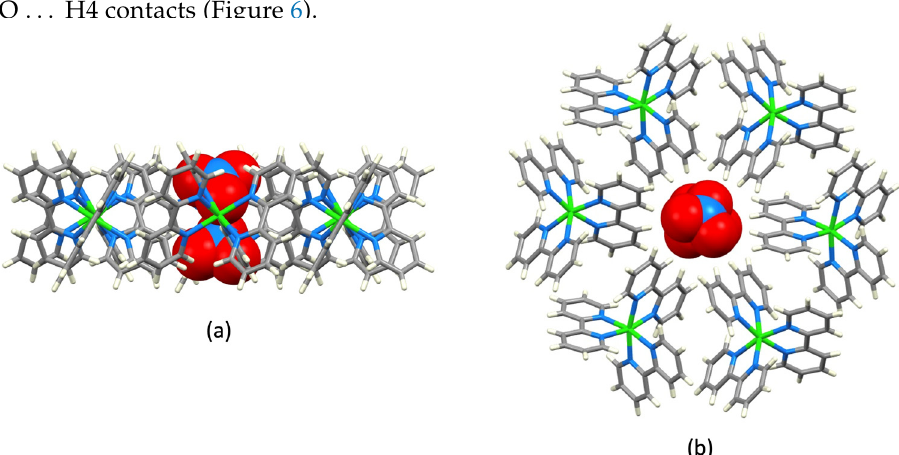
Figure 5. Structure Type II illustrated with the motif found in [Zn(bpy) 3 ][NO 3 ][azt] 0.5 . 6H 2 O which possesses a sheet structure (refcode OLOCOI) [47]. ( a ) One hexagonal motif which hosts two [NO 3 ] – ions, and ( b ) the same unit viewed from above.